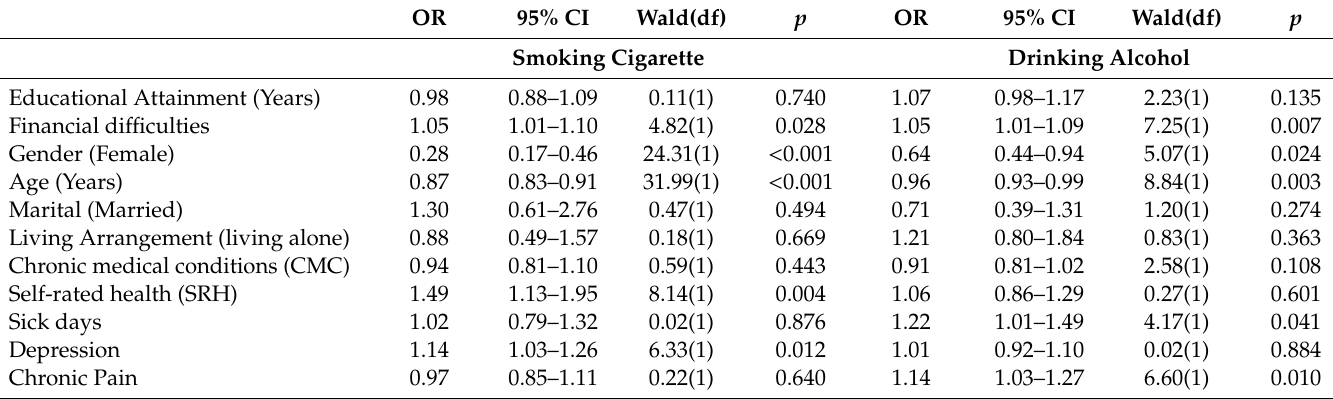
Table 3. Summary of two multivariable logistic regression models with smoking cigarettes and drinking alcohol as